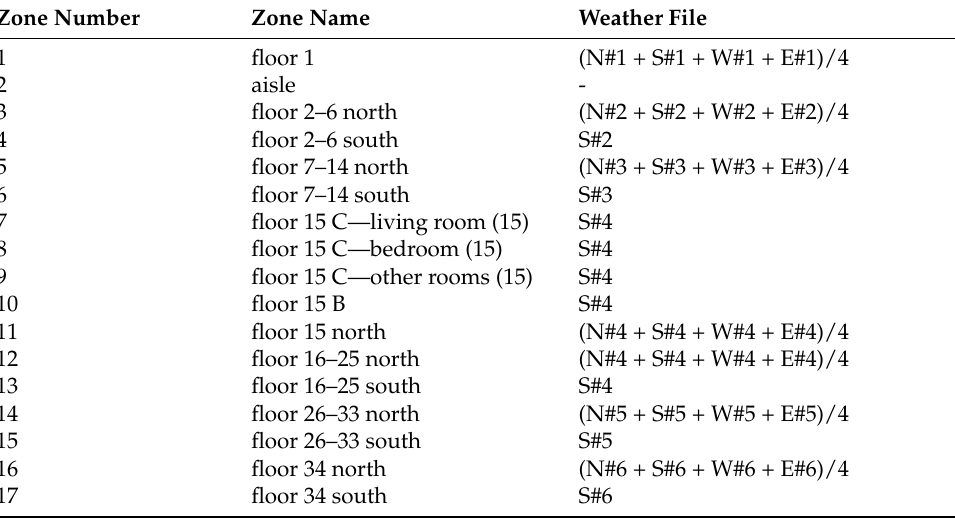
Table 6. Meteorological files to calculate the energy load of each